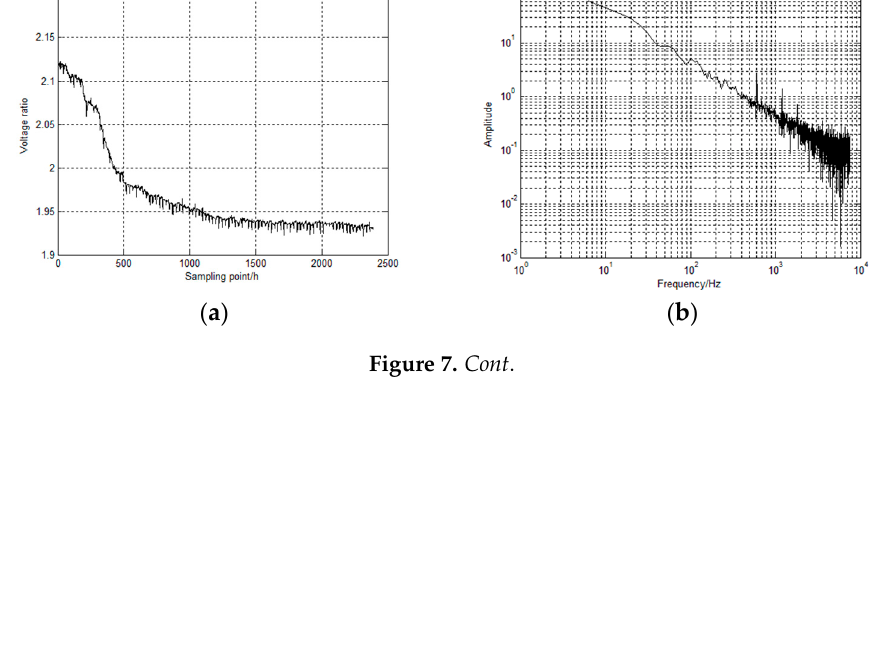
Figure 6. Flowchart of an adaptive denoised method based on variational mode decomposition (VMD).